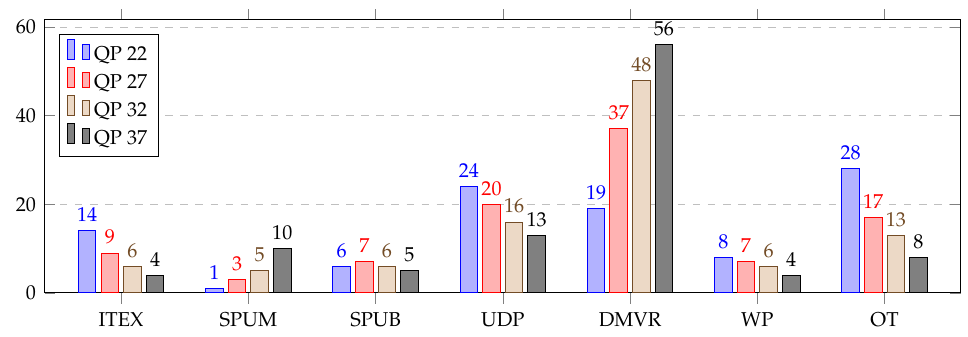
Figure 7. Average time distribution for different parts of the inter prediction (in %) over the HGPP.